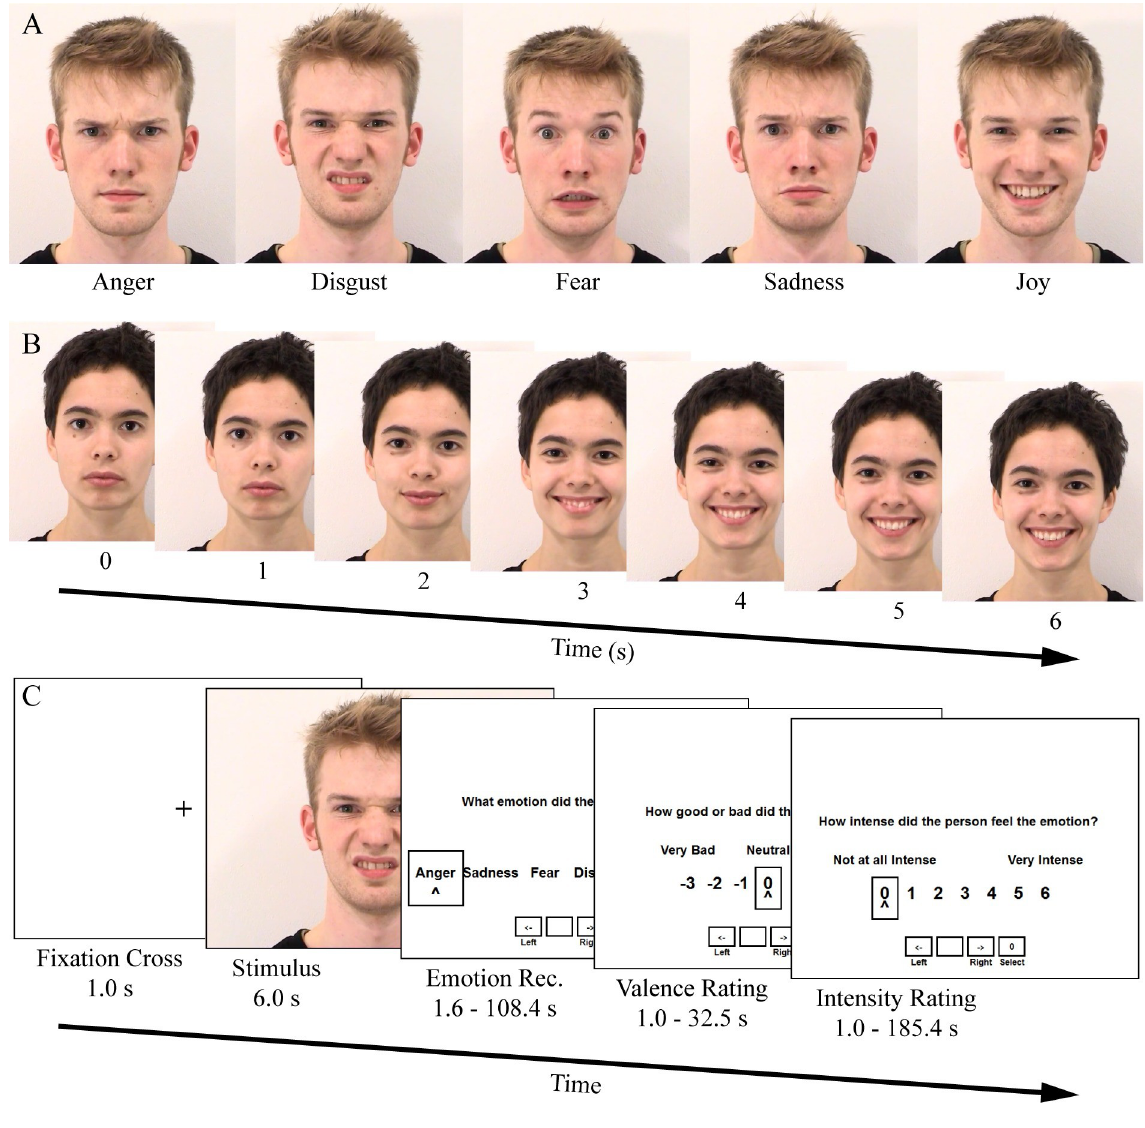
Fig 1. Prototypical facial expression task. A) Examples of each prototypical facial expression of emotion from the Amsterdam Dynamic Facial Expression Set, captured at the peak of each expression (about 3–4 s after stimulus onset). B) Time course of an example video. The target person transitioned from a neutral facial display to an emotional expression around 1–2 s after stimulus onset. C) Time course of a single trial. A fixation cross was followed by the stimulus, then by response screens for emotion categorization, valence rating, and intensity rating of the target person’s facial emotion